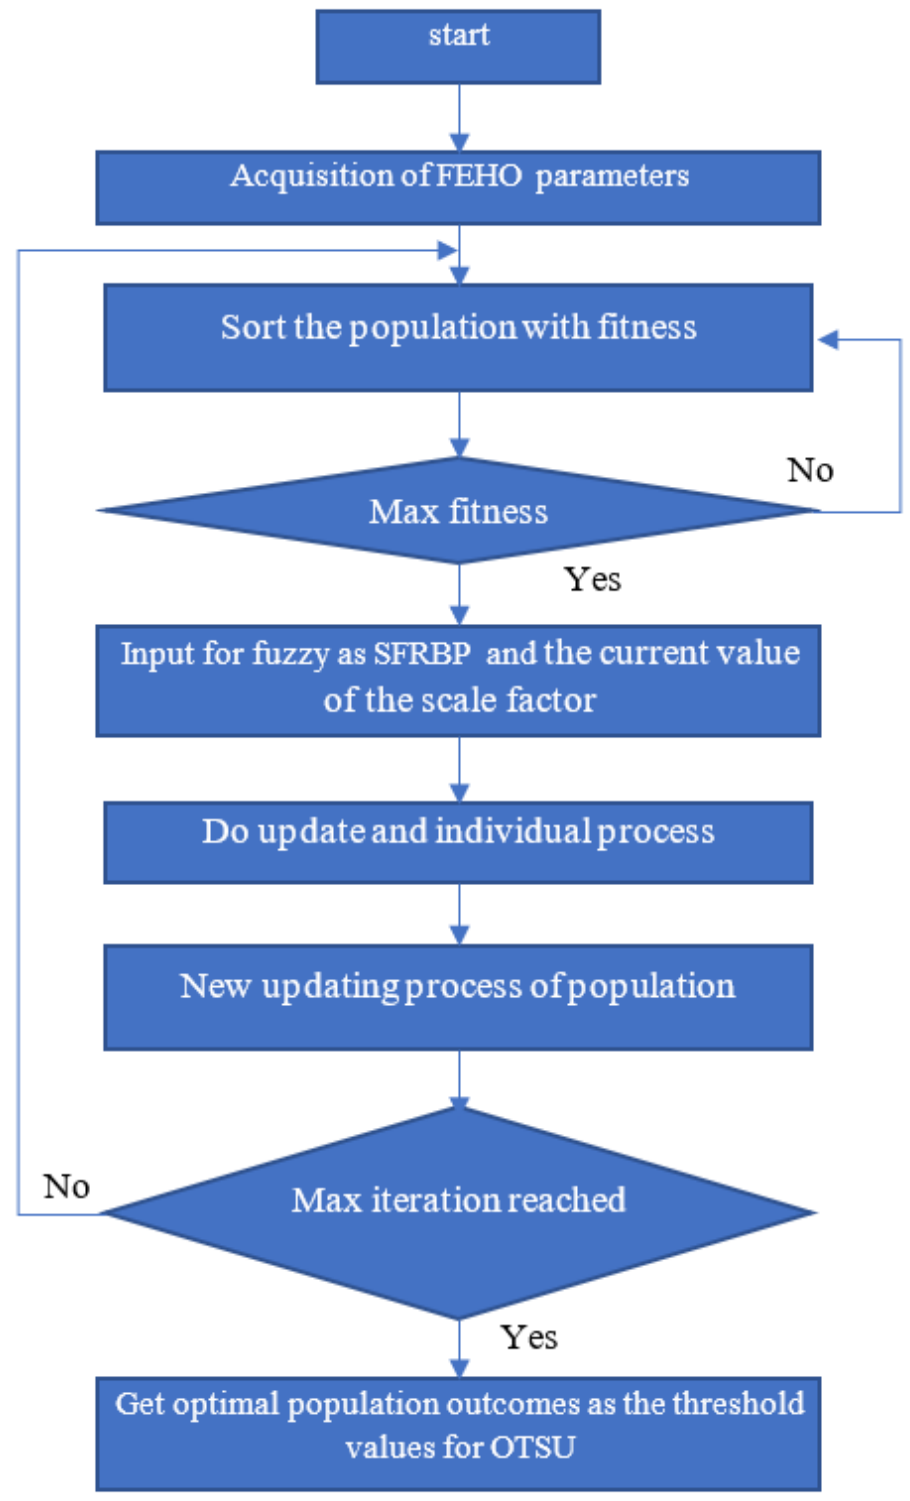
Figure 2. Flow chart of EFEHO to OTSU.